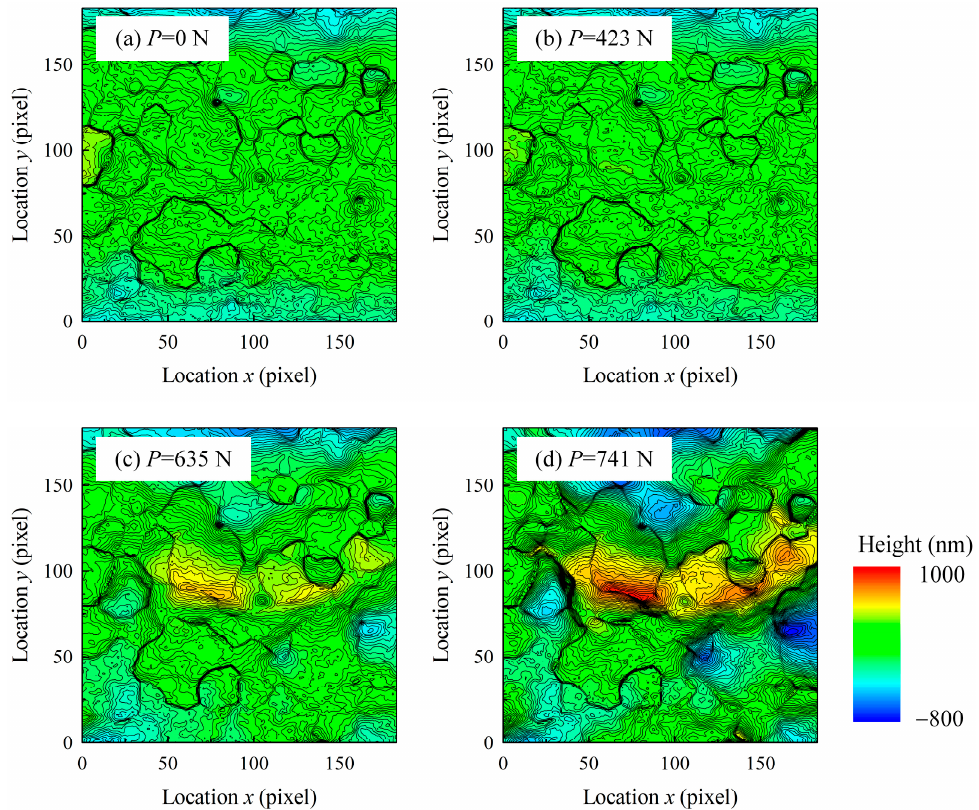
Figure 4. Height distribution at four load steps (1 pixel = 4.443 μ m) [24].